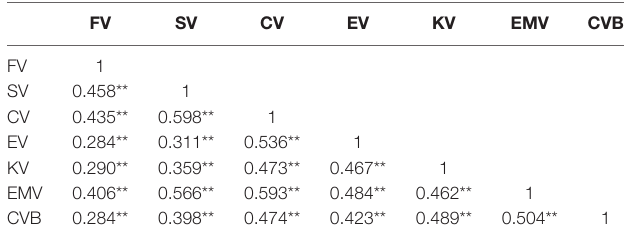
TABLE 6 | Descriptive statistics of variables in the study conducted in China. Constructs/variables